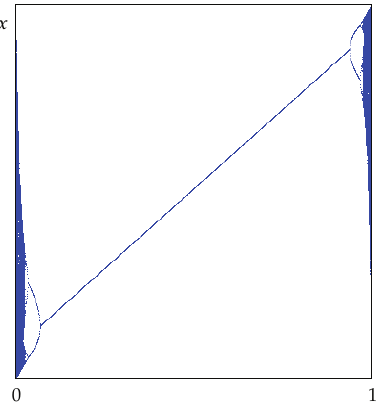
Figure 1: Bifurcation diagram.